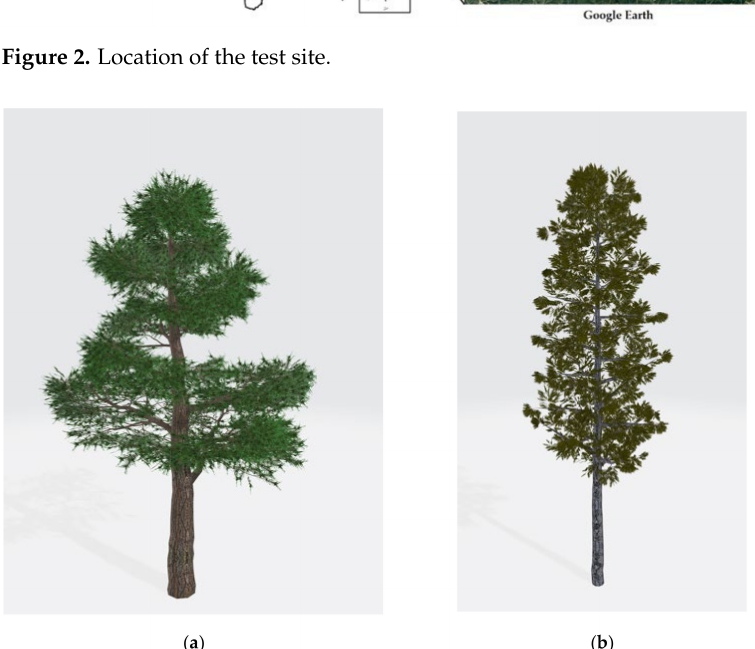
Figure 3. Schematic diagram of a single tree of Chinese Pine and Larix Principis. ( a ) Chinese Pine; ( b ) Larix